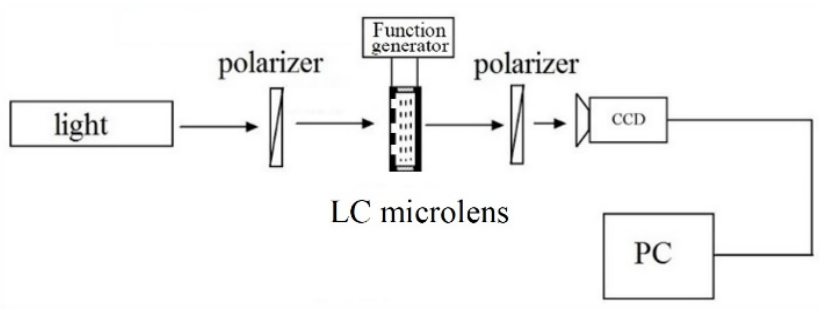
Figure 7. Experimental setup for measuring the classic electro-optical features of the proposed LC microlens.